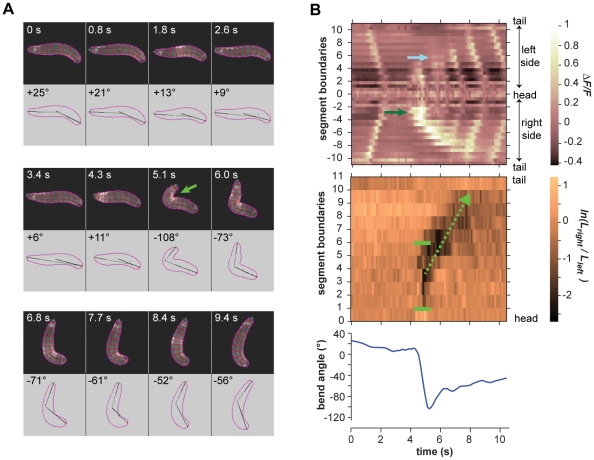
Turning decisions with large head sweeps.
A. Video frames of an example large rightward head sweep during cooling. Upper panel in each video frame shows fluorescence image. Outline and boundaries between segments are shown in red. Lower panel in each video frame shows the perimeter, centerline, and body bend angle as analyzed by machine vision software. Green arrow shows the asymmetric bend that is flagged as a head sweep. B.
(Upper panel) Kymograph of fluorescence intensity within body segments for the video segment shown in A. Green arrow shows the greater increase in fluorescence intensity on the right side of the animal, signifying the rightward head sweep. Blue arrow shows the increase in fluorescence intensity in the A3 segment, signifying the resumption of peristalsis near the bend. (Middle panel) Kymograph of the logarithm of the ratio between the lengths of segment boundaries on the left side and right side of the animal. Green brackets indicate the margins of the region of asymmetric contraction, negative values signifying the rightward bend. Green arrow shows the retrograde progression of the region of asymmetric contraction during subsequent peristalsis waves. (Lower panel) Time course of body bend angle, operationally defined to flag reorientation maneuvers as described in Materials and Methods, shows the initial drop that signifies the rightward head sweep and gradual rise as subsequent peristalsis waves straighten the body.